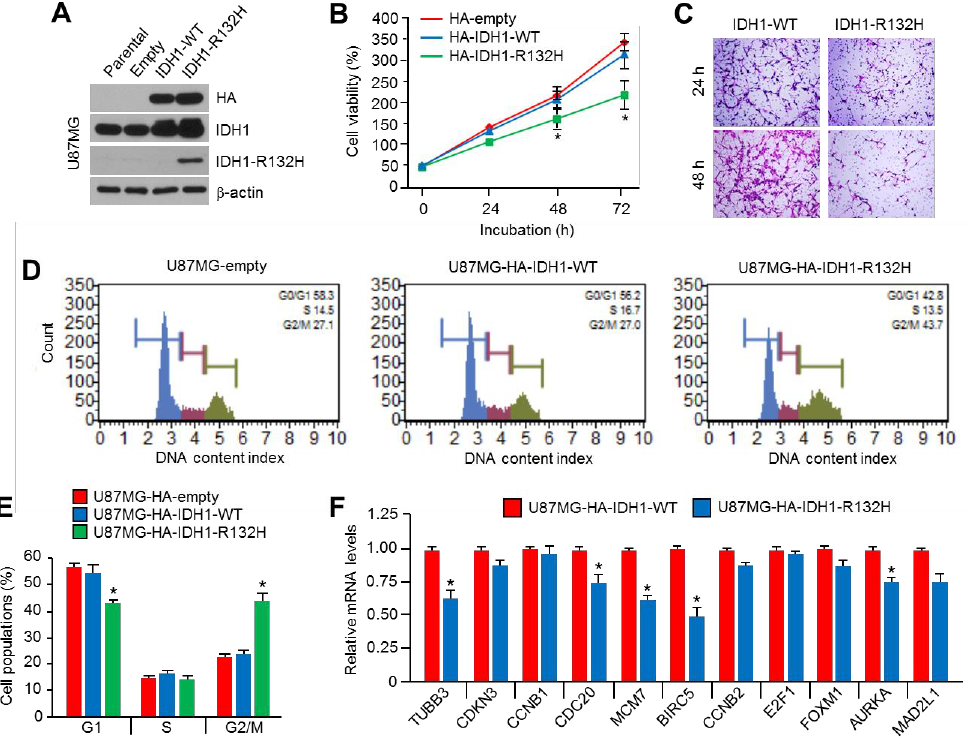
Figure 1. IDH1 R132H suppresses mitotic cell cycle and motility in U87MG glioblastoma cells. ( A ) Generation of IDH1 R132H overexpressing U87MG cells. IDH1 R132H overexpression was confirmed by using western blotting. ( B ) Overexpression of IDH1 R132H suppresses cell viability in U87MG cells. The stable cell lines were incubated for 24, 48, and 72 h, as indicated. Cell viability was measured by using crystal violet staining and assay. The values represent the mean ± SD of three independent experiments performed in triplicate; * p < 0.05. ( C ) Overexpression of IDH1 R132H suppresses cell motility in U87MG cells. Transwell chamber was used for in vitro cell migration assay. The stable cells were incubated for 24 or 48 h into upper chamber with MEM- α without fetal bovine serum (FBS) and 10% FBS containing culture medium was added into bottom chamber as chemotaxis. Decreased cell motility was shown as hematoxylin and eosin (H&E) stained images. ( D ) Overexpression of IDH1 R132H suppresses cell cycle at G2 / M phase in U87MG cells. The stable cells were incubated for 24 h. Alteration of cell cycle progression was shown. ( E ) Quantitative cell population was shown. The values represent the mean ± SD of two independent experiments performed in triplicate; * p < 0.05. ( F ) Overexpression of IDH1 R132H suppresses cell cycle promoting genes expression in U87MG cells. The stable cells were incubated for 24 h, and then cell cycle promoting genes expression was measured by using qRT-PCR. The values represent the mean ± SD of three independent experiments performed in triplicate; * p < 0.05.